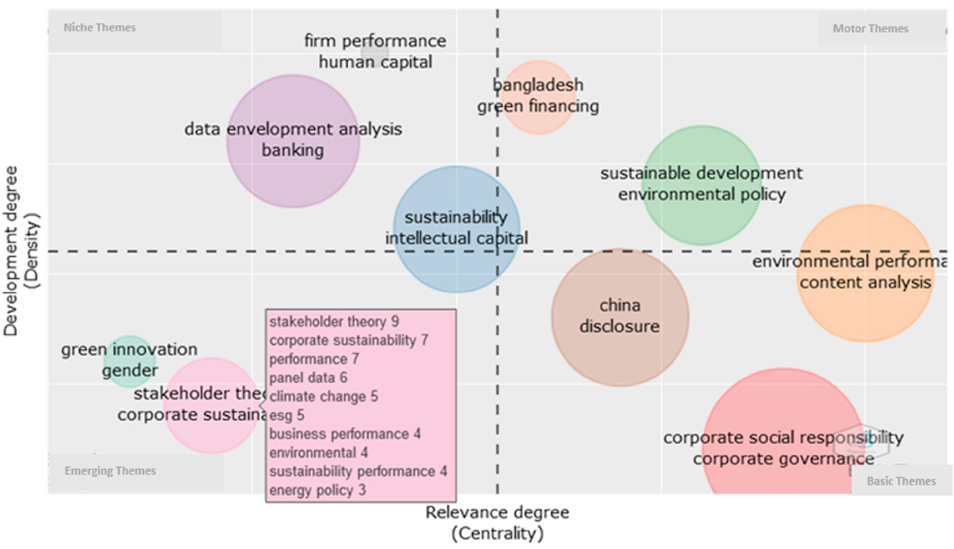
Figure 2. Thematic map. Source: Scopus/Biblioshiny.